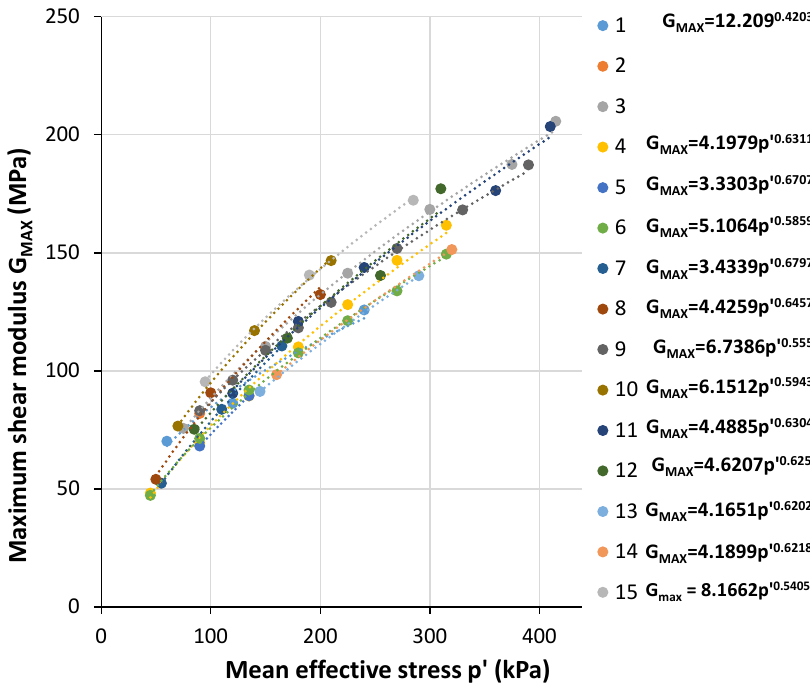
Figure 2. Maximum shear modulus G MAX against mean effective stress p’.